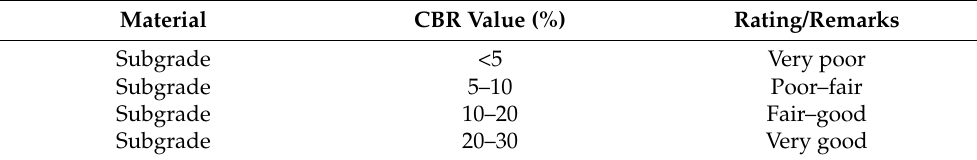
Table 6. Relative ratings of CBR values for subgrade.